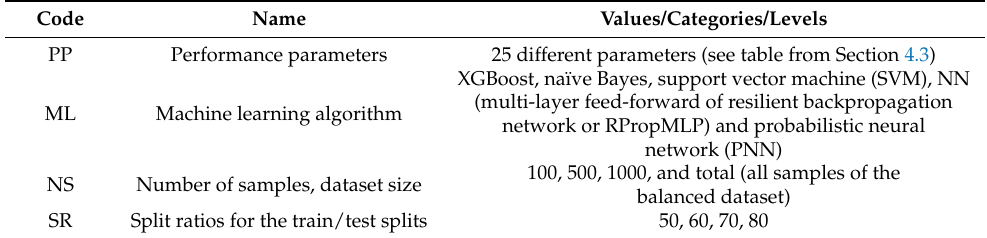
Table 2. Labels and levels of the different factors.